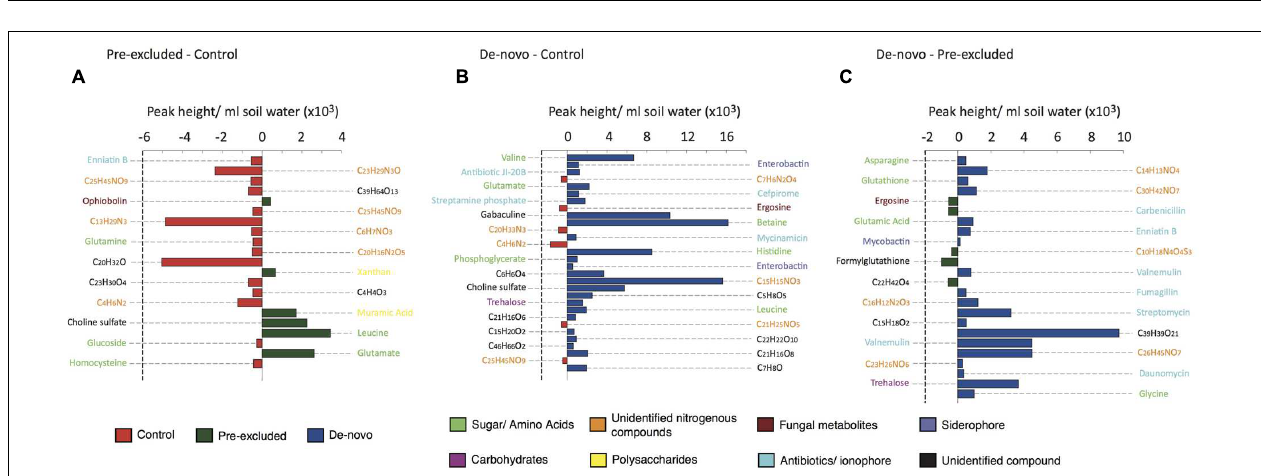
FIGURE 1 | Changes in metabolomic profiles in treatment vs. control soils. (A) Weighted canonical correspondence analysis (CCA) of the complete set of metabolites produced by LC-MS 2 analysis. The ordination is the product of a correlation of functional diversity with physicochemical factors (abbreviations: NH 4 , ammonia; NO 3 , nitrate; K, potassium; Na, sodium; Mg, magnesium; WP, water potential; WC, water content; Fe, iron; P, phosphate; DOC, dissolved organic carbon; Ca, calcium). (B) Abundance of selected broad classes of metabolites. Stars above the plots denote significant differences when compared with the control.